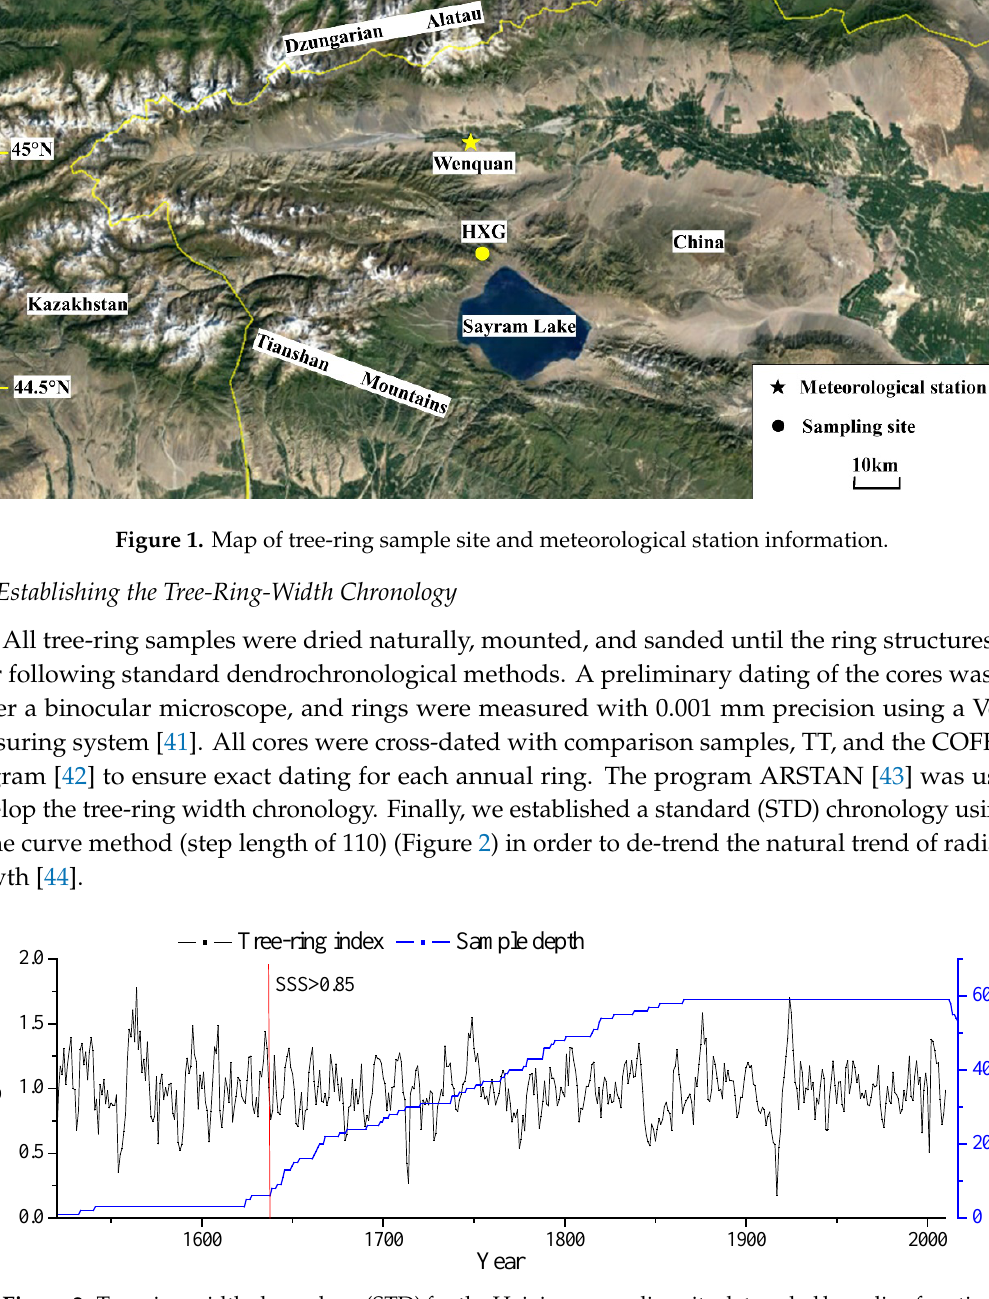
Figure 2. Tree-ring width chronology (STD) for the Haixigou sampling site detrended by spline function.